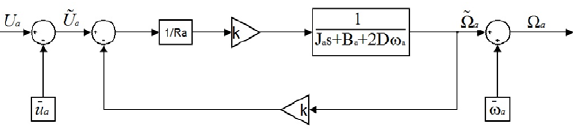
Figure 2. Block diagram of the linear DC motor model in the working point